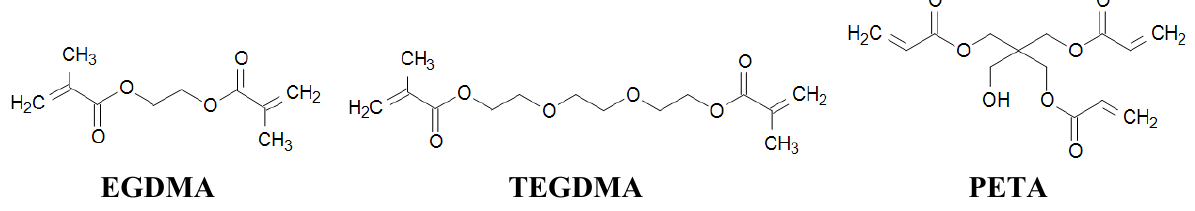
Figure 3. Structures of cross-linkers